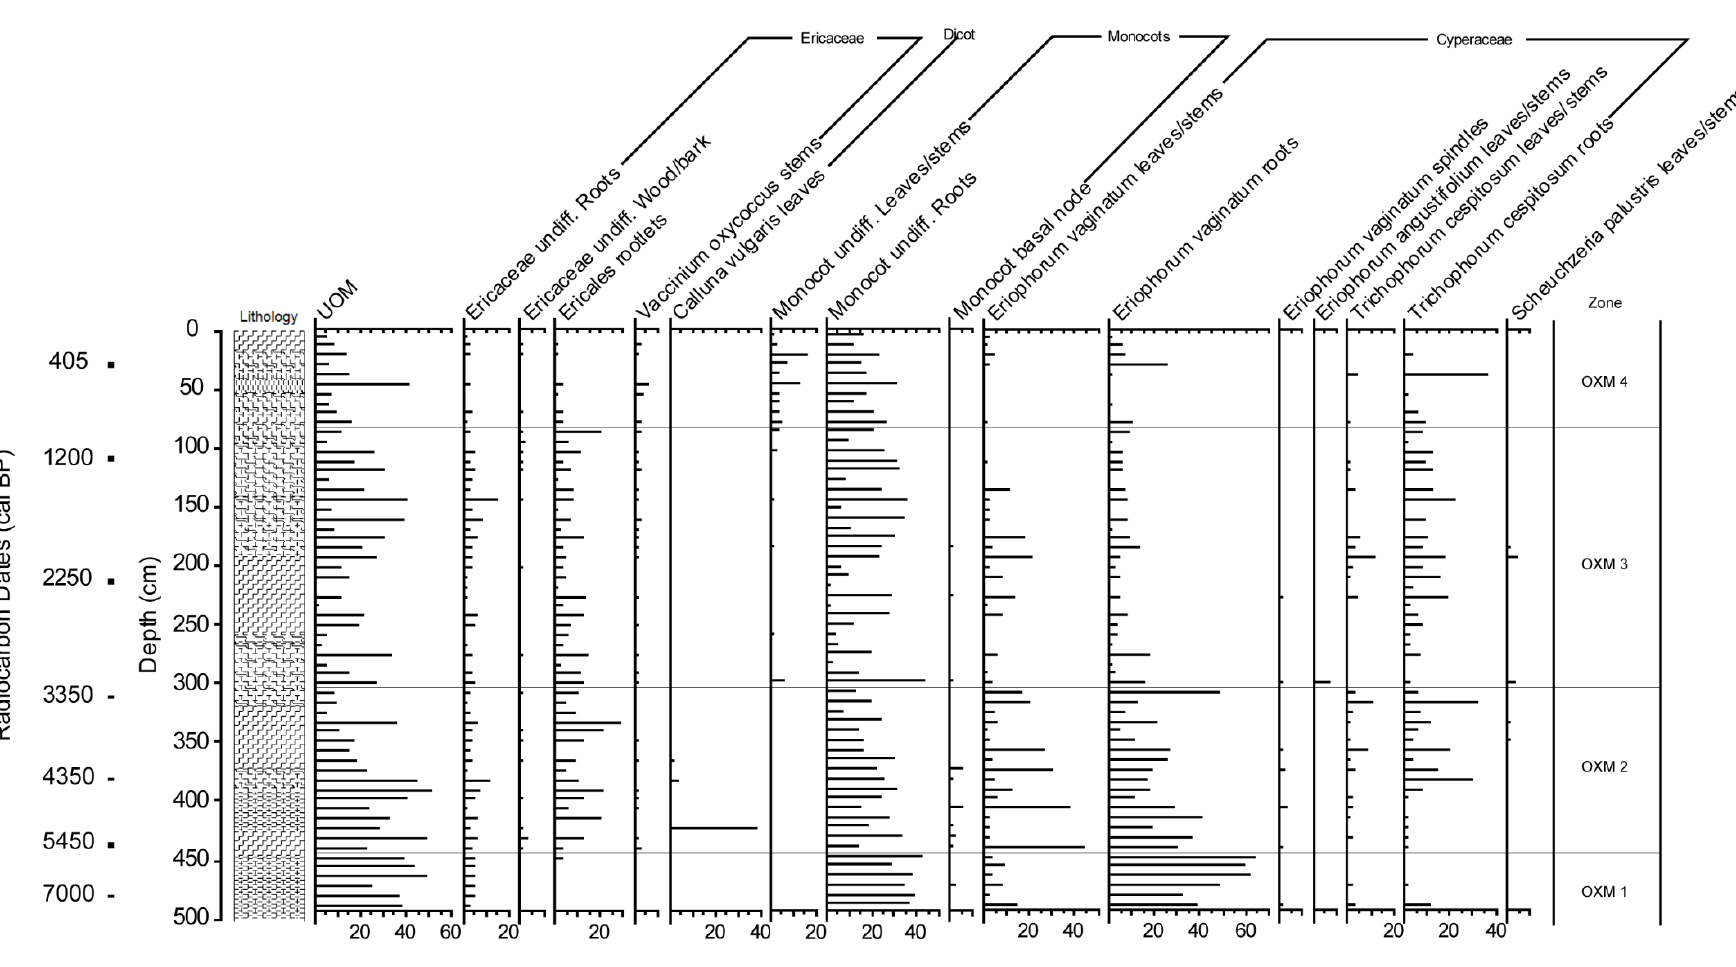
Figure 4 (part). Plant macrofossil percentages using: depth (cm), radiocarbon ages (cal. BP), and lithology (Troels-Smith 1955). Continued